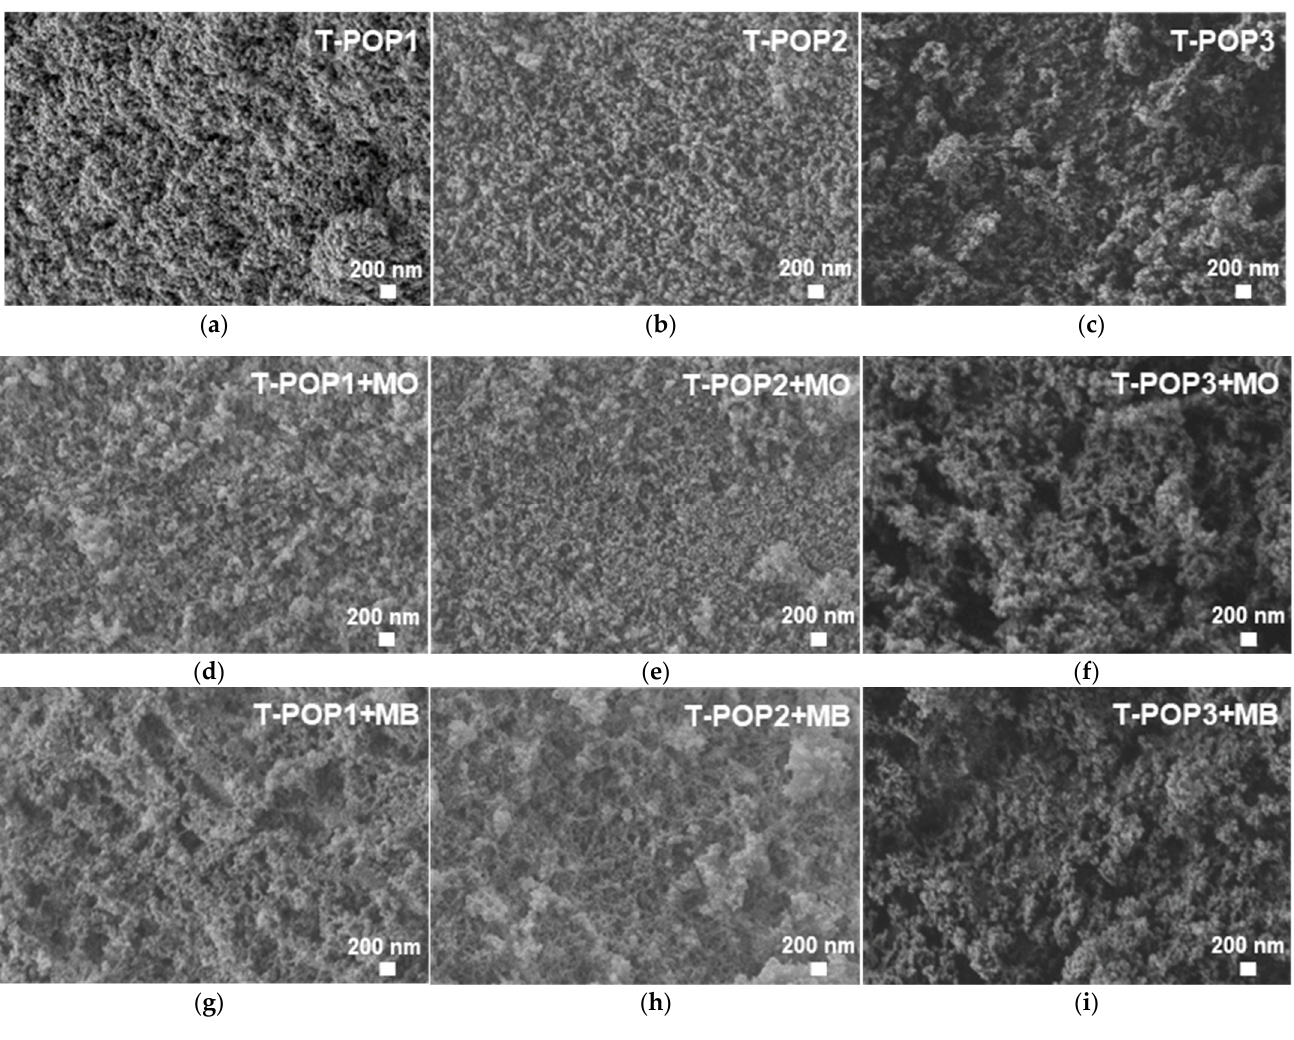
Figure 6. SEM micrographs of neat ( a ) T-POP1, ( b ) T-POP2, and ( c ) T-POP3; after adsorption of methyl orange (MO): ( d ) T-POP1+MO, ( e ) T-POP2+MO, and ( f ) T-POP3+MO; and after sorption of methylene blue (MB): ( g ) T-POP1+MB; ( h ) T-POP2+MB, and ( i ) T-POP3+MB. Magnification 20,000×.